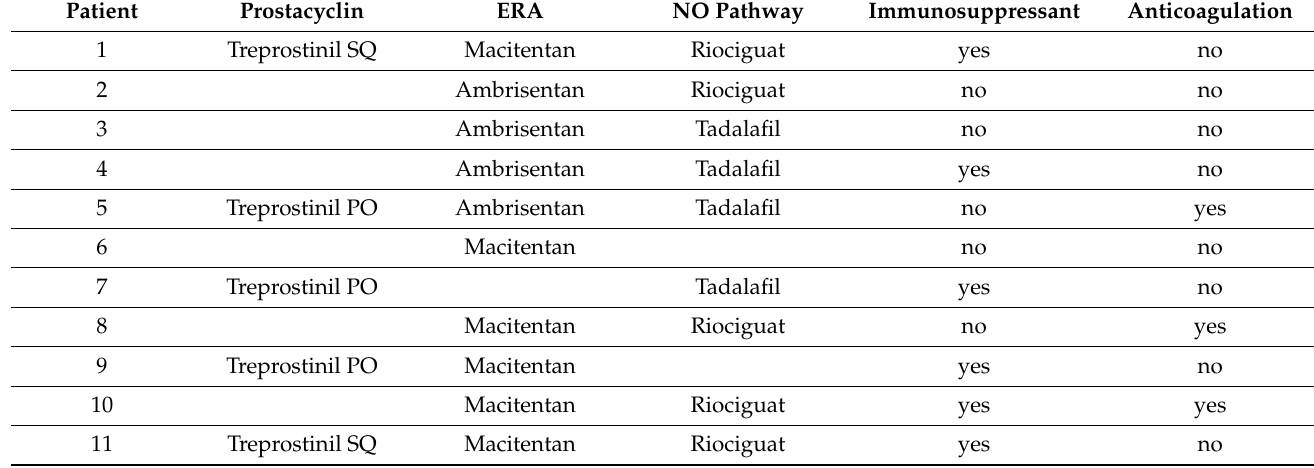
Table 2. Medications.